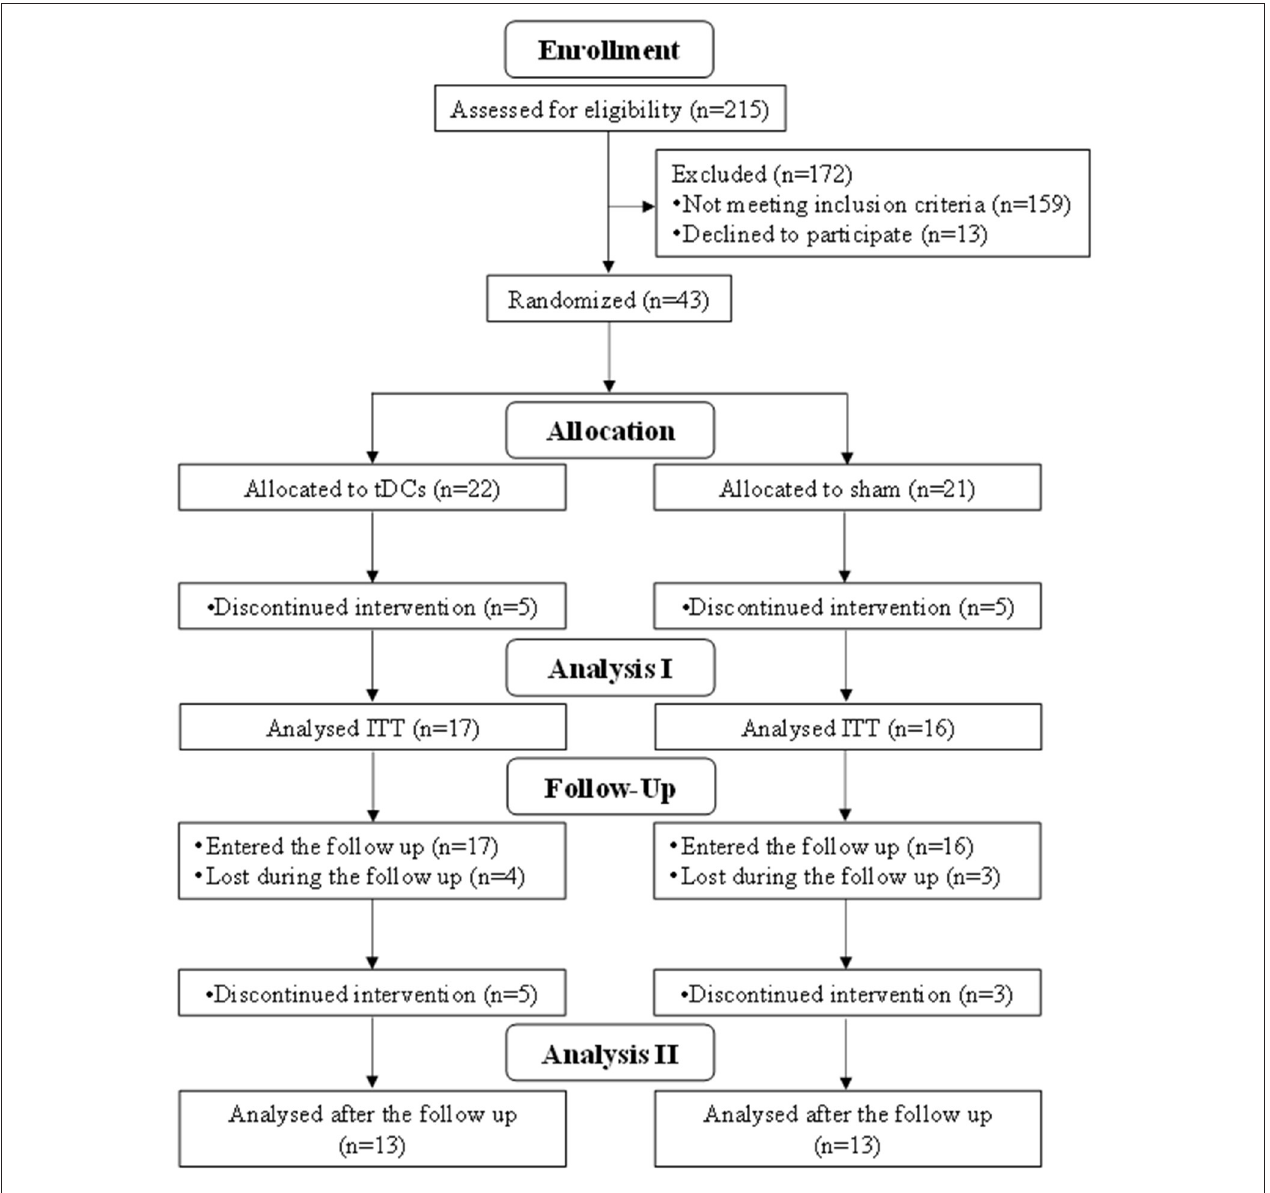
FIGURE 1 | Enrollment to the